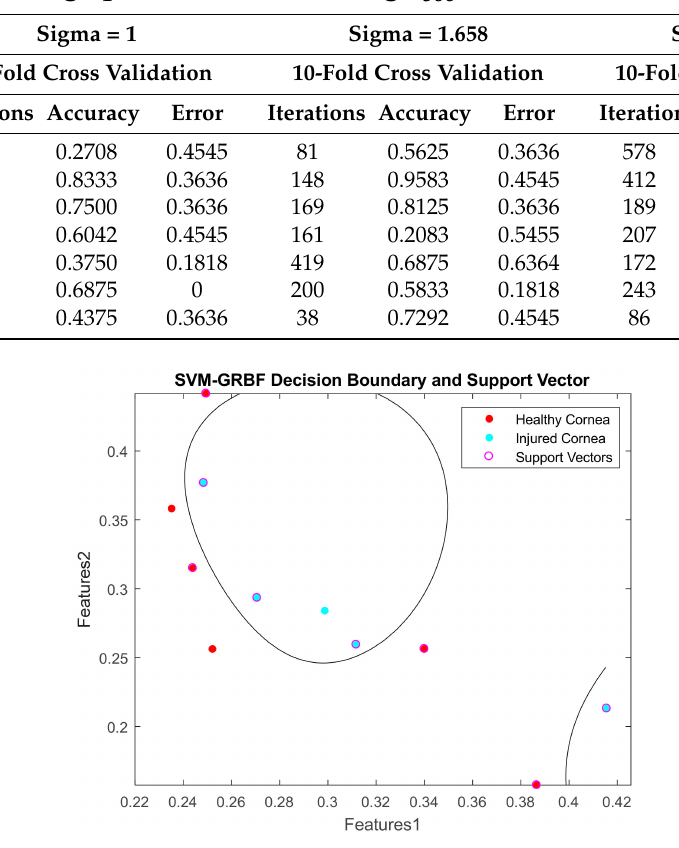
Figure 19. Decision boundary and support vector for Mean vs Skewness (testing data). Table 5. Confusion